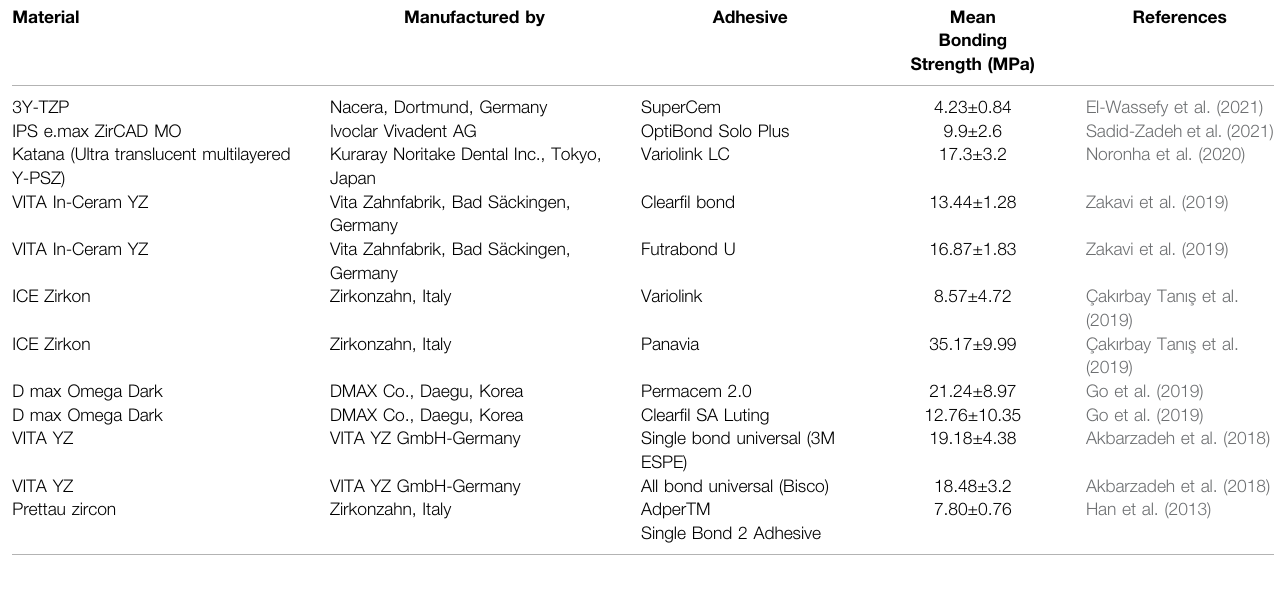
TABLE 2 | Experimental studies on resin bonded dental zirconia.